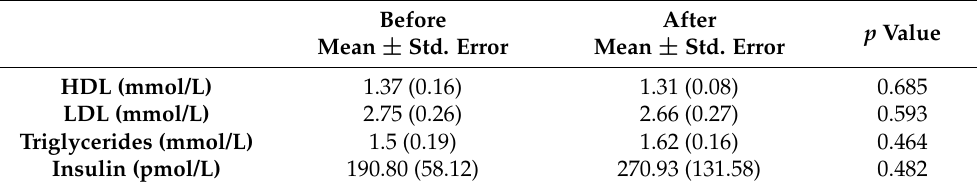
Table 2. Clinical variables changes following intervention.